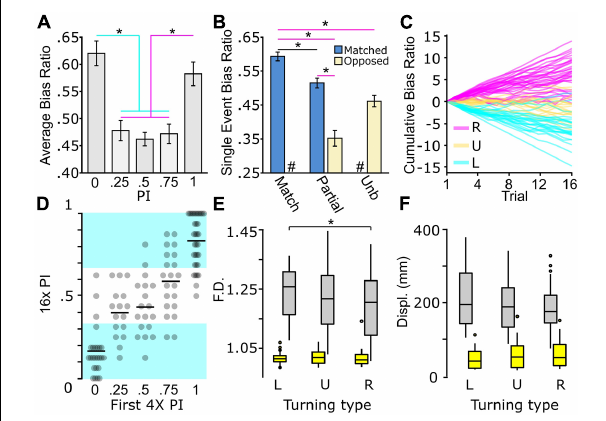
FIGURE 2 | Biased and unbiased motor types present during light-search. (A) Absolute bias ratio from 4 × recording per PI (PI 0, N = 66; PI 0.25, N = 74; PI 0.5, N = 75; PI 0.75, N = 75; PI 1, N = 67). (B) Absolute bias ratio magnitude for single 30 s recordings occurring in a direction matching (blue) overall average PI direction or occurring in the opposed (beige) direction shown for perfect bias (0,1 PI, N = 517), partially biased (0.25, 0.75 PI, N = 596), and unbiased (0.5 PI, N = 301) populations. (C) Cumulative summation of bias ratio over the q4 × from strong right (magenta, N = 34), strong left (cyan, N = 34), and unbiased (yellow, N = 18) individuals. Individuals were selected based on the first 4 × average PI (strong right PI = 1, strong left PI = 0, unbiased PI = 0.5). (D) Average q4 × PI based on initial 4 × PI (PI = 0, N = 66; PI = 0.25, N = 74; PI = 0.5, N = 75; PI = 0.75, N = 75; PI = 1, N = 67). Black bars represent sample mean. Left, right, and unbiased performance categorized within equal thirds of the PI scale. Cyan background highlights average PI with left or right turning type behavior. (E,F) Characterization of path trajectory features during baseline (yellow boxes) and dark (gray boxes) responses from individuals tested in the q4 × assay. Turning type determined by 16 × average PI distribution in (D) . (E) Fractal dimension and (F) Displacement (L, left, N = 36; U, unbiased, N = 40; R, right, N = 38). Asterisk p <